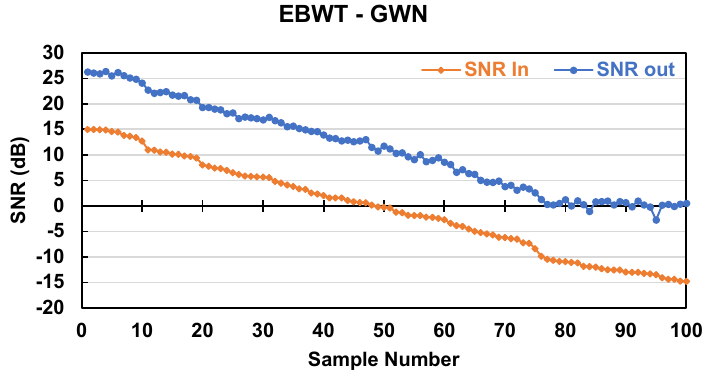
Figure 19. SNR of 100 samples of PD signals contaminated with GWN. Maximum ∆ SNR = 14.89 dB, minimum ∆ SNR = 3.8 dB, and average = 6.8 dB.